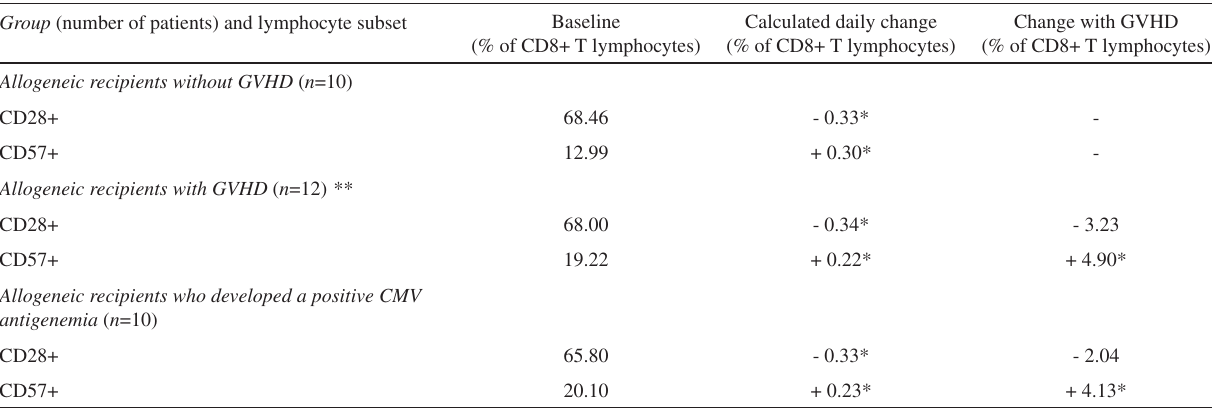
Group (number of patients) and lymphocyte subset Baseline